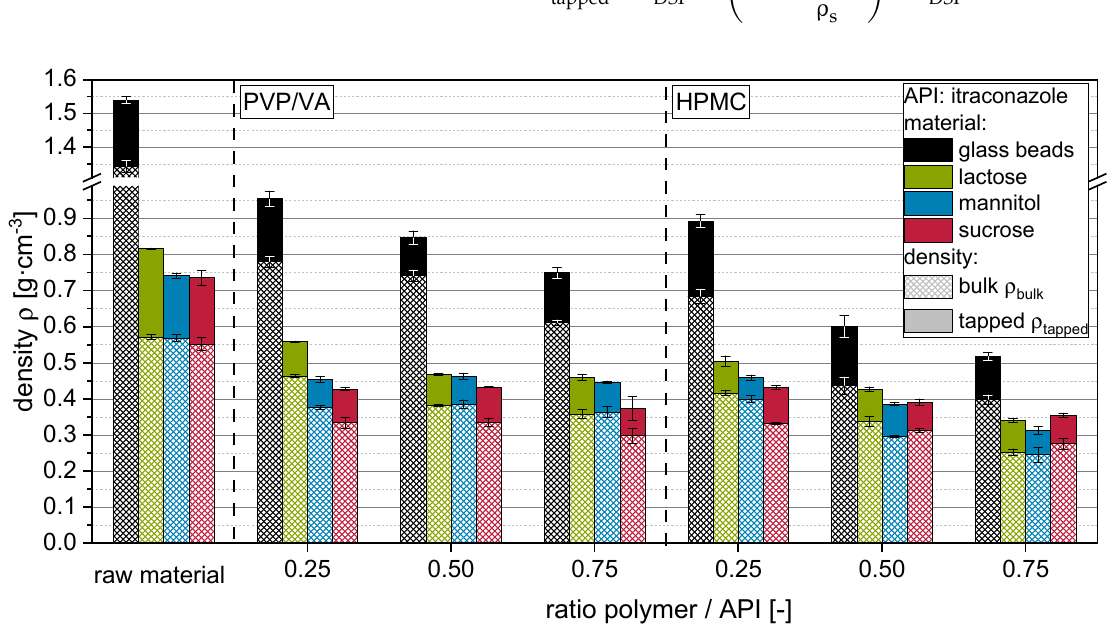
Figure 4. Bulk ( ρ bulk ) and tapped ( ρ tapped ) densities of raw carrier materials (i.e., glass beads, lactose, mannitol, sucrose) and corresponding nanoparticle-loaded granules produced with itraconazole nanosuspensions with different ratios of polymer (either PVP/VA or HPMC) to API. The solid densities ρ S of the granules were calculated by considering the solid densities of the incorporated raw materials with the corresponding proportions. Values for the porosity increase ∆ ε of the raw materials and granules are depicted in Figure 5. Additionally, the ∆ ε of the granules is depicted after normalization to the ∆ ε of the raw materials in order to accentuate the influence of the applied amount and type of polymer on the porosity of the granules.